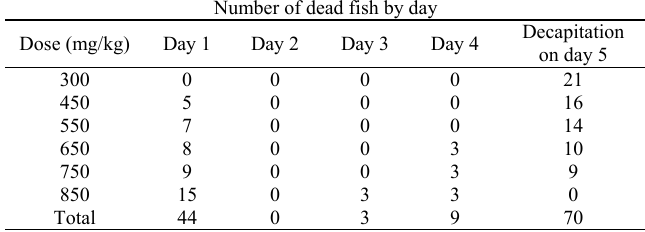
Table 3: Daily numbers of dead Caspian kutum after injection with different doses of fipronil Number of dead fish by day